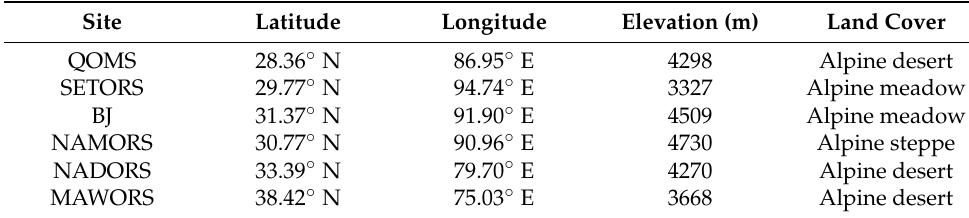
Table 1. List of the geographic characteristics of the six sites [19].